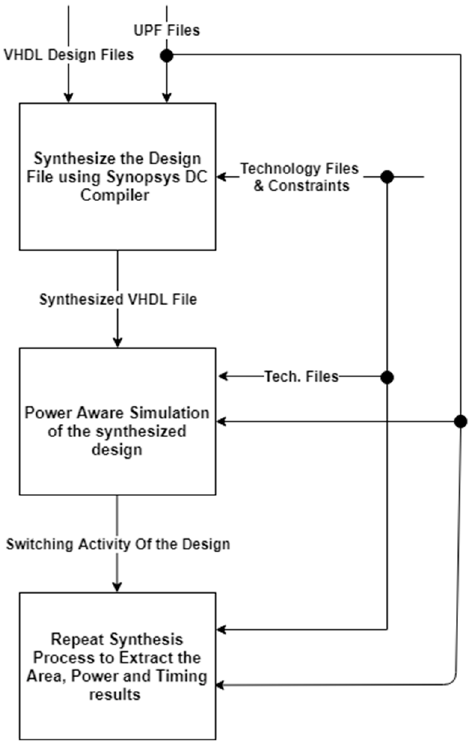
Figure 14. The power-aware simulation and synthesis flow.